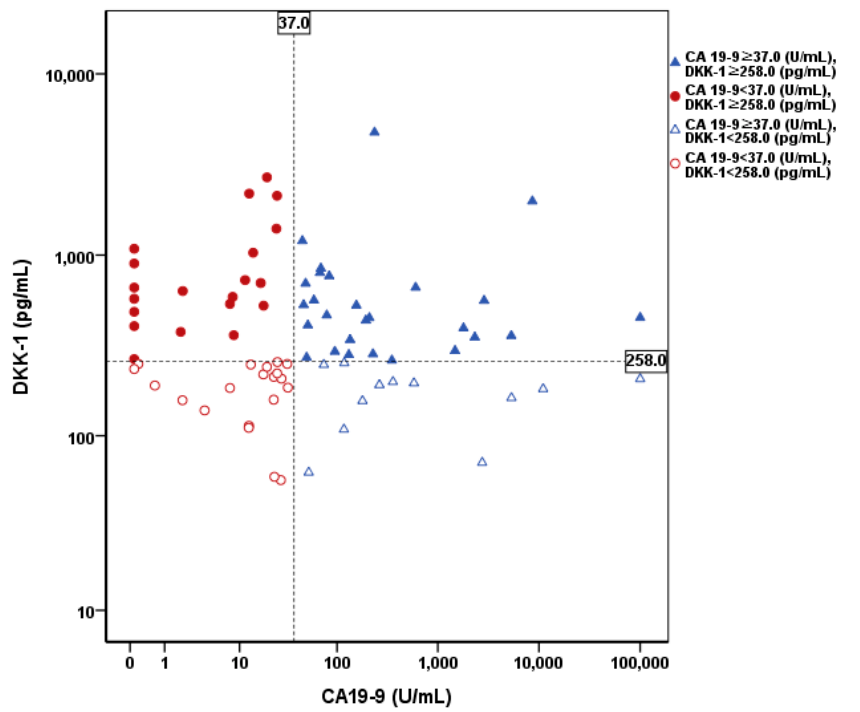
Figure 3. Distribution of DKK-1 and CA 19-9 levels in patients with ICC. The cutoff value of DKK-1 and CA 19-9 were 258.0 pg/mL and 37.0 U/mL, respectively. Twenty out of 40 patients with false negative CA 19-9 were additionally diagnosed using DKK-1. The diagnostic yield of DKK-1 was 50%. DKK-1, Dickkopf-related protein 1; CA 19-9, carbohydrate antigen 19-9; ICC, intrahepatic cholangiocarcinoma.